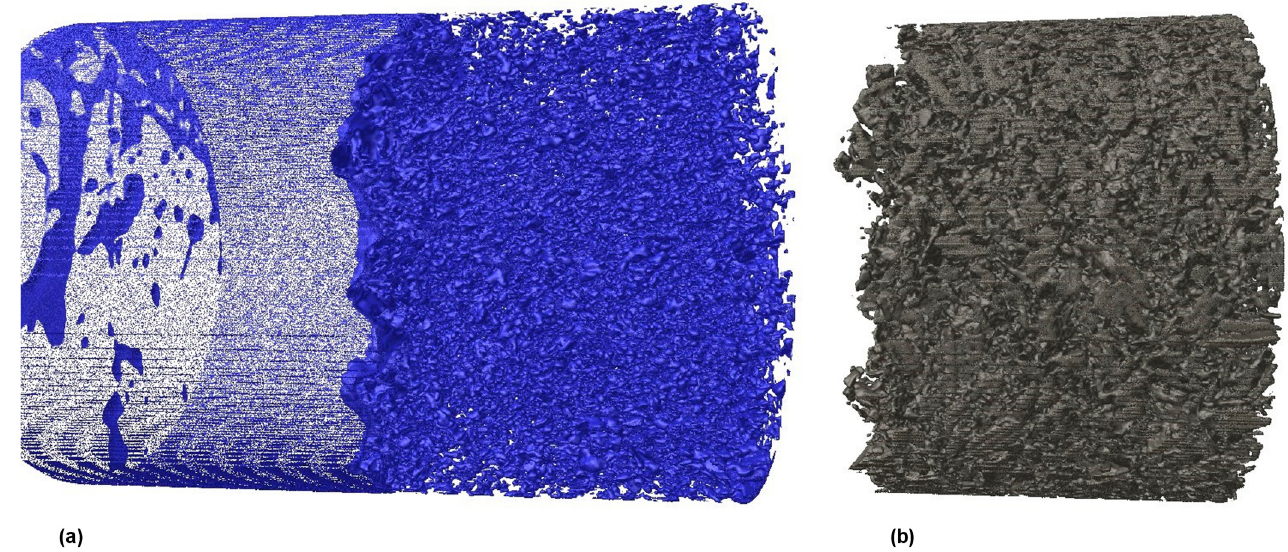
Figure 12. X-ray computed tomography scan of a sample of blended oil sands tailings and clay shale overburden, showing ( a ) tailings and ( b ) clay shale overburden.